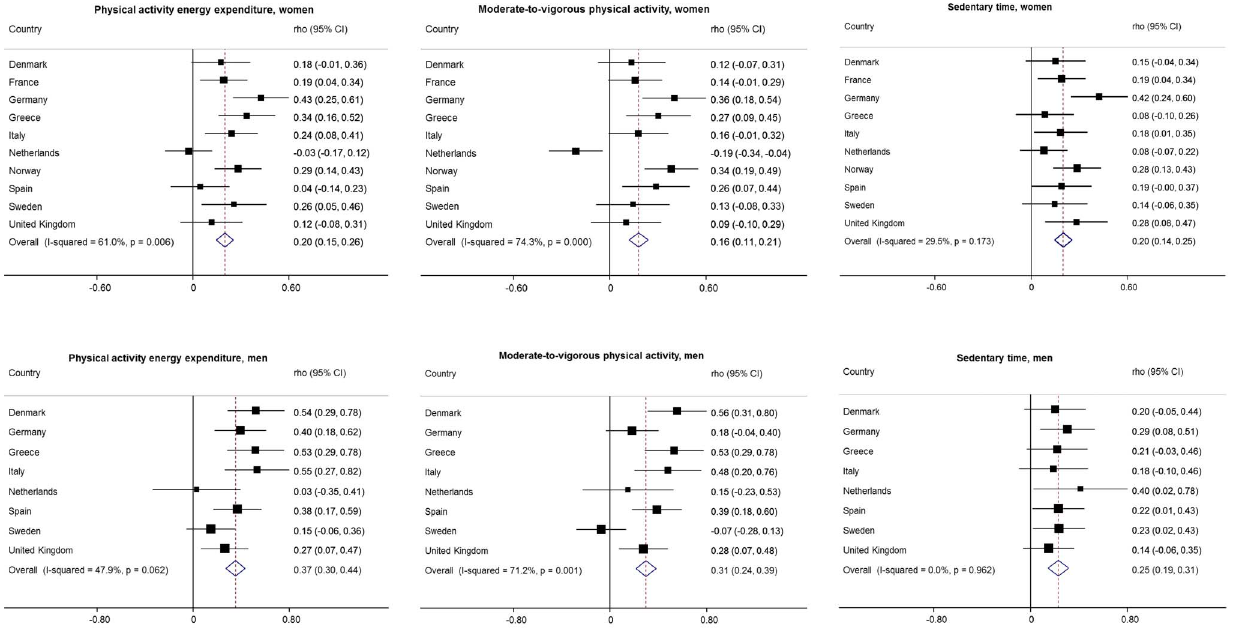
Figure 1. Spearman’s correlation coefficients for the associations of PAEE, MVPA and sedentary time assessed by the RPAQ with objectively measured corresponding variables by country and sex in 1343 women and 540 men.